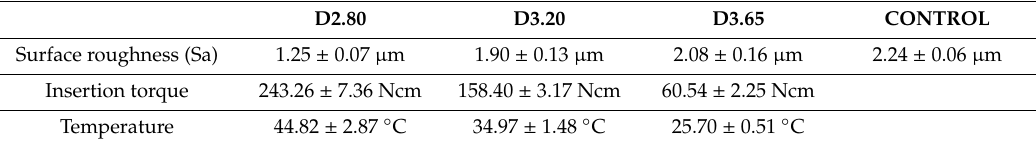
Table 2. Average roughness, insertion torque and implant surface temperature values for the di ff erent implant groups. The values presented are averages and standard errors for each group of implants placed in implant beds of various